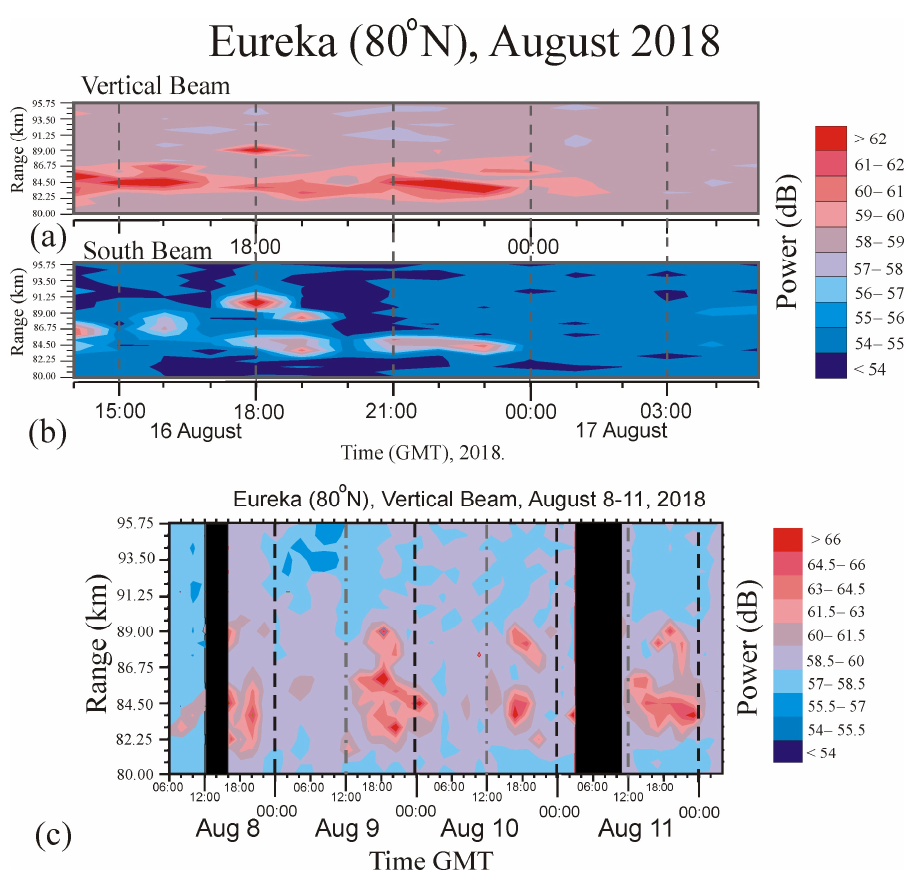
Figure 3. Contour plots of signals from ~80 to ~95 km altitude measured at Eureka, Canada. ( a ) and ( b ) show PMSE observed with a vertical beam and an off-vertical beam pointing southward, using 20 min averages, for Aug 16–17, 2018. ( c ) Shows 4 days of data, using 2-h averages, measured on a vertical beam.